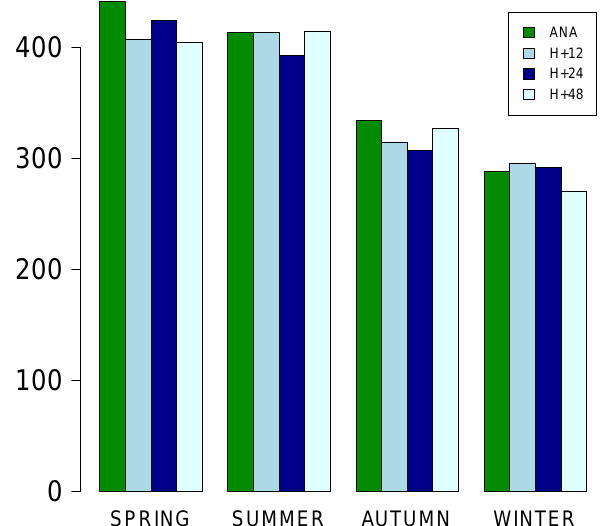
Fig. 1. Number of detected cyclonic centres in the m.s.l.p. analyses